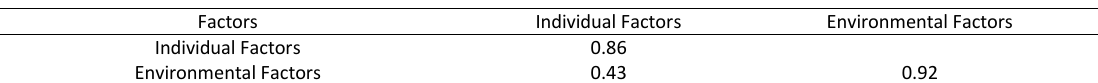
Table 8: Fornell and Larker matrix (divergent validity)